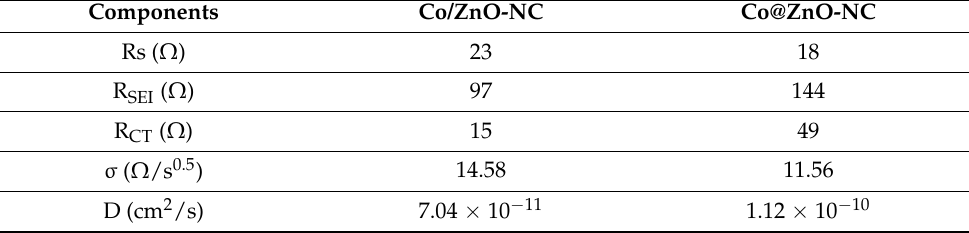
Figure 9. ( a ) Nyquist plots for Co@ZnO-NC and Co/ZnO-NC electrodes; ( b ) Corresponding Randles plots for Co@ZnO-NC and Co/ZnO-NC electrodes. Table 1. R SEI , R CT , and diffusion coefficient of Li in Co/ZnO-NC and Co@ZnO-NC